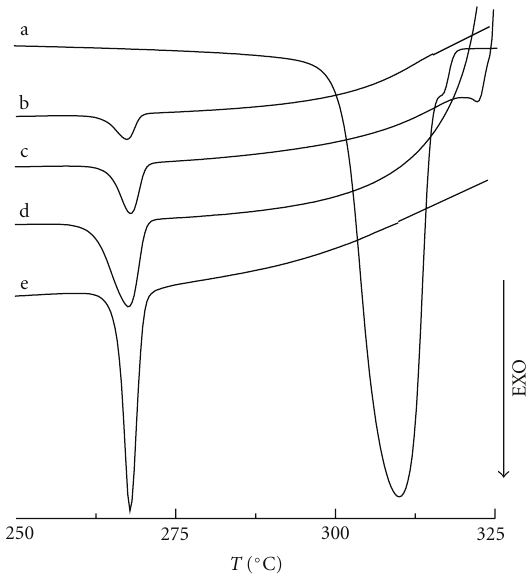
Figure 9: DSC cooling at 20 ◦ C/min after fast heating to 330 ◦ C of samples BP44 (a), BPM4 (b), BPM5 (c), BPM6 (d), and BPM8 (e).